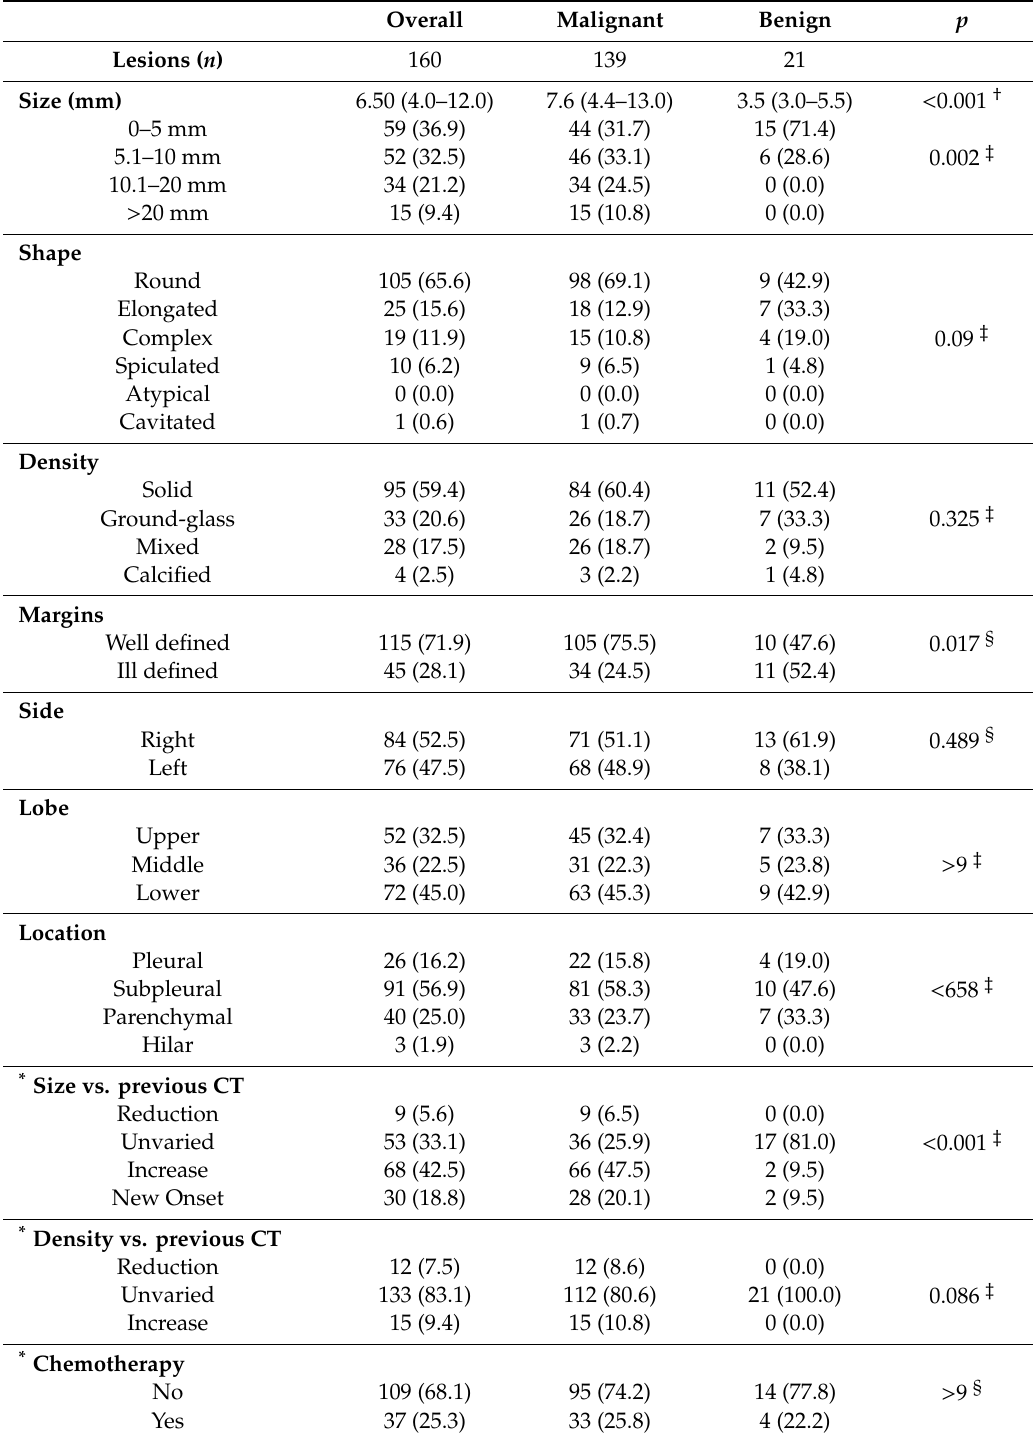
Table 2. Pulmonary nodule